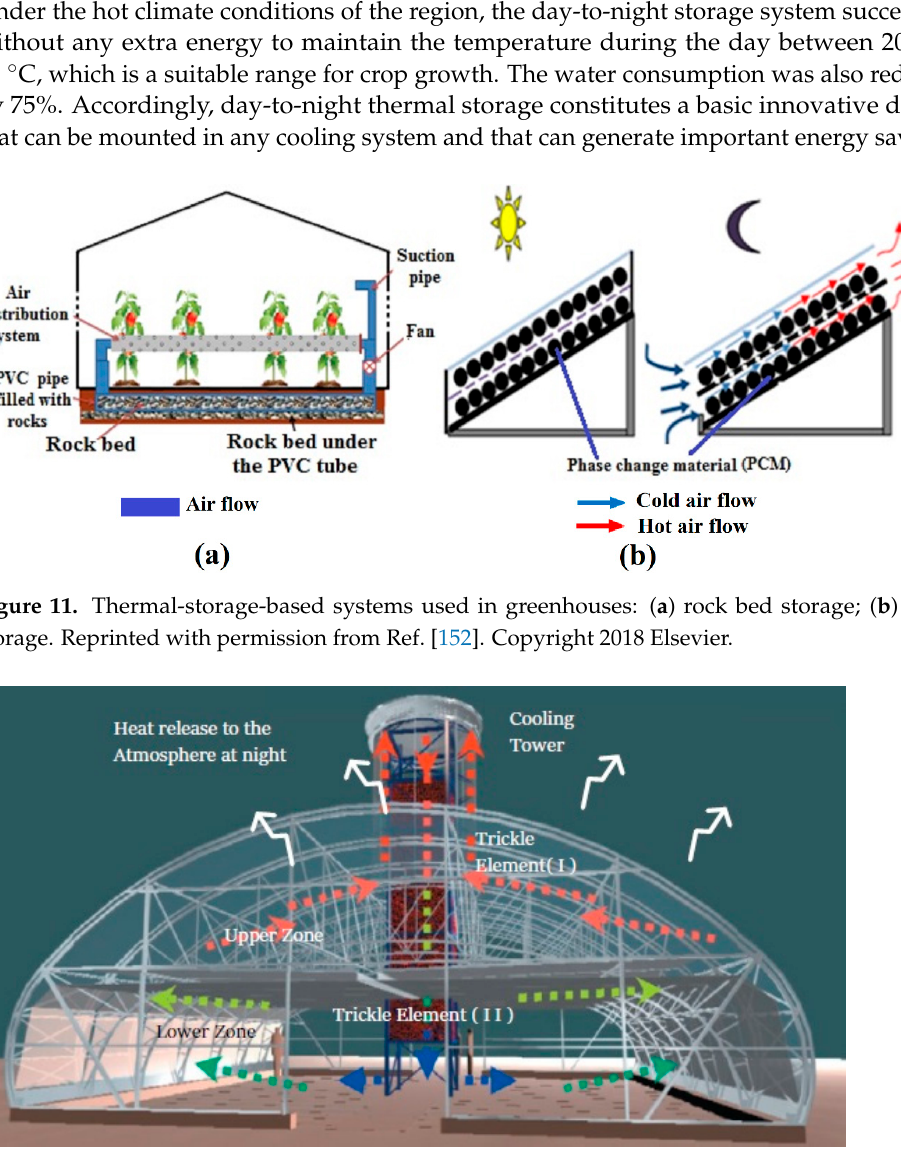
Figure 12. Air circulation in the greenhouse cooled by the day-to-night thermal storage system. Adapted from [131].